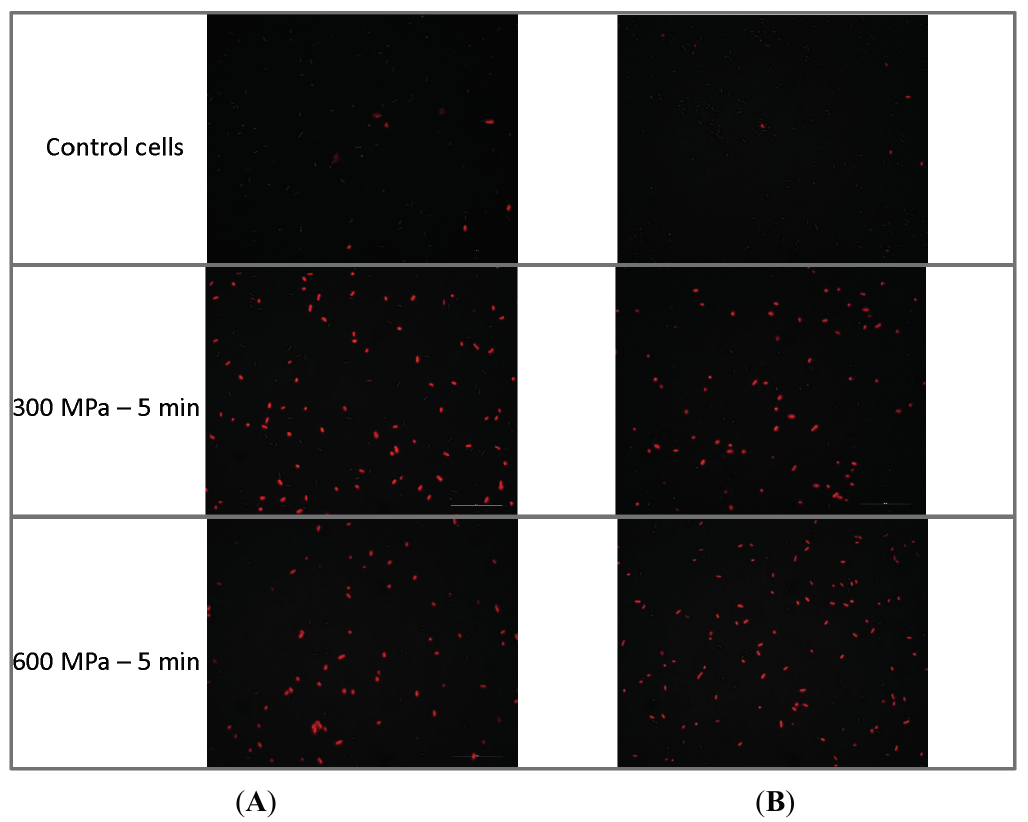
Escherichia coli C-600 ( B ) untreated or treated with HHP at 300 MPa and 600 MPa followed by fluorescence microscopy.